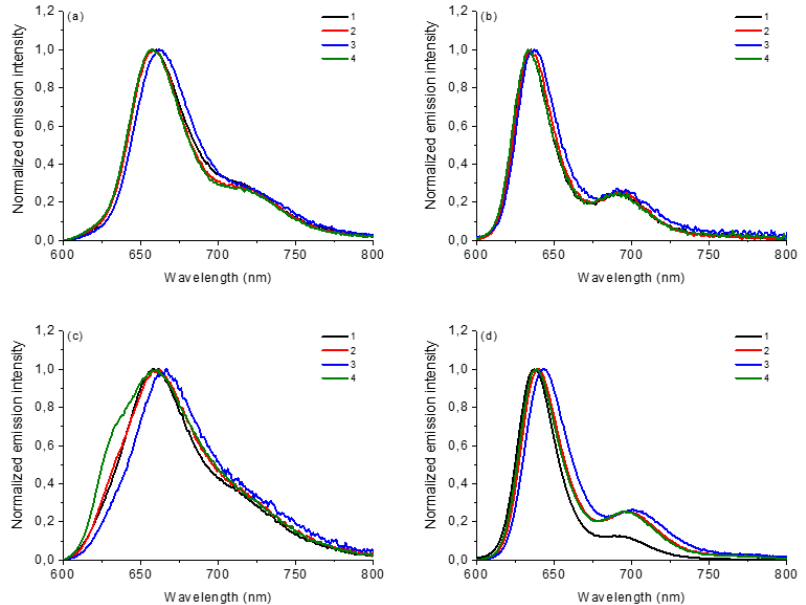
Figure 3. Normalized steady-state fluorescence emission spectra of corroles 1 – 4 in ( a ) DCM, ( b ) ACN, ( c ) MeOH and ( d ) DMSO, at concentration of 5.0 μM ( λ exc at Soret transition band). ( c ) MeOH and ( d ) DMSO, at concentration of 5.0 µ M ( λ exc at Soret transition